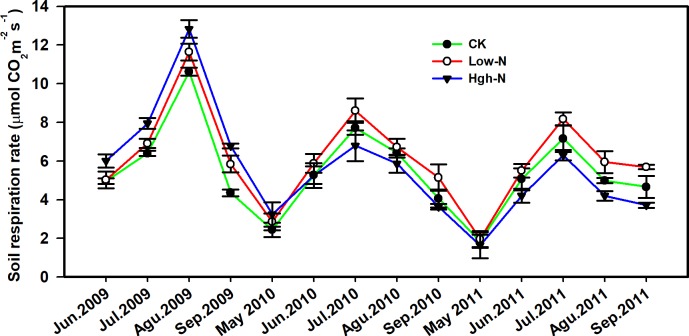
Seasonal dynamics of soil respiration rate in relation to N treatment during 2009–2011.